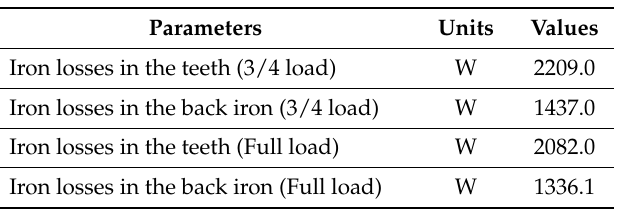
Figure 25. By = f(Bx) for two different zones of the stator. In the tooth ( a ) the field is rotating and c i = 0.7 in this example. In the back iron ( b ) the field is alternating and c i = 0. Table 9. Losses in the stator